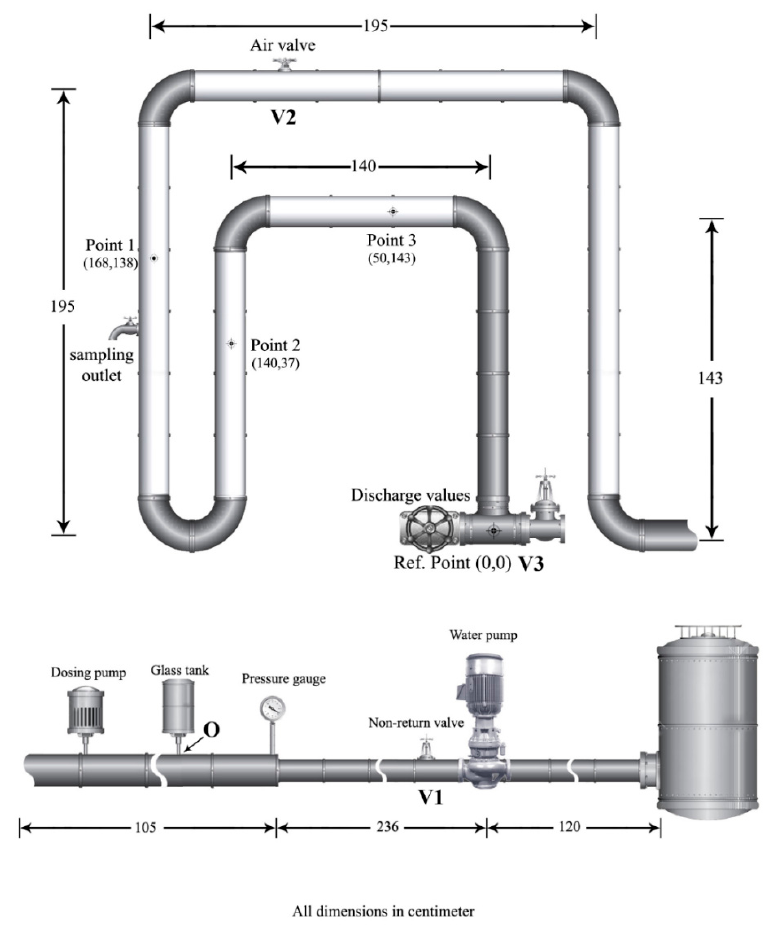
Figure 1. Schematic of the pilot drinking water network.